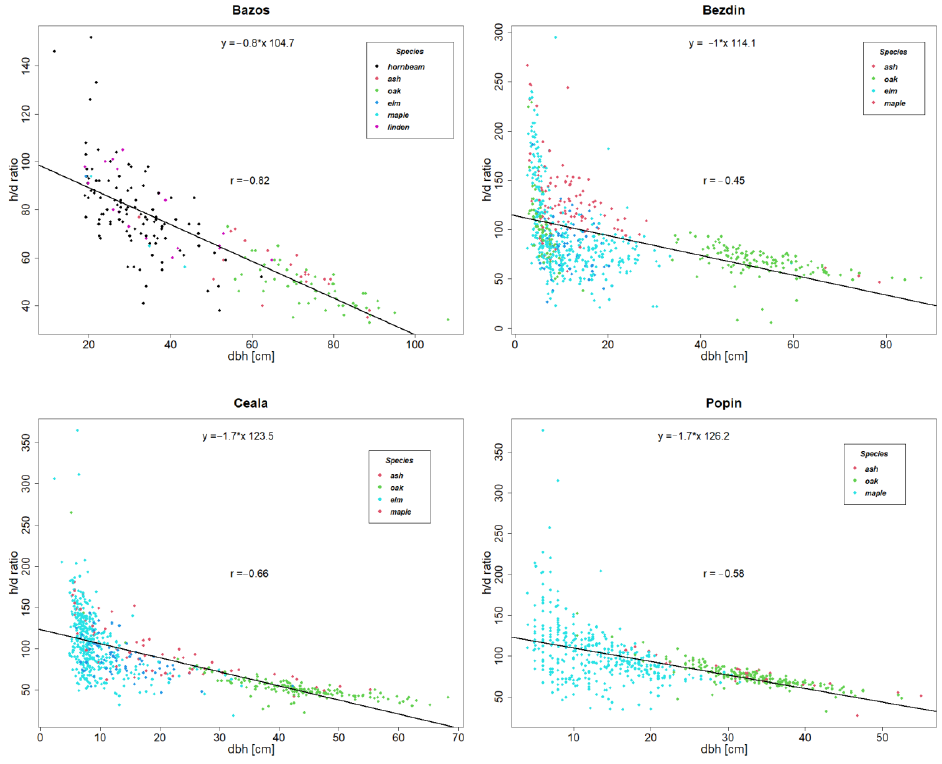
Figure 3. Diameter distribution in relation to species and height-to-diameter ratio.